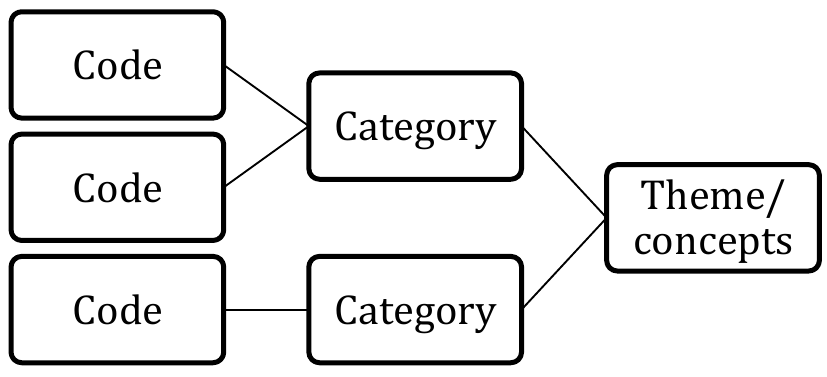
Figure 1. Data Analysis